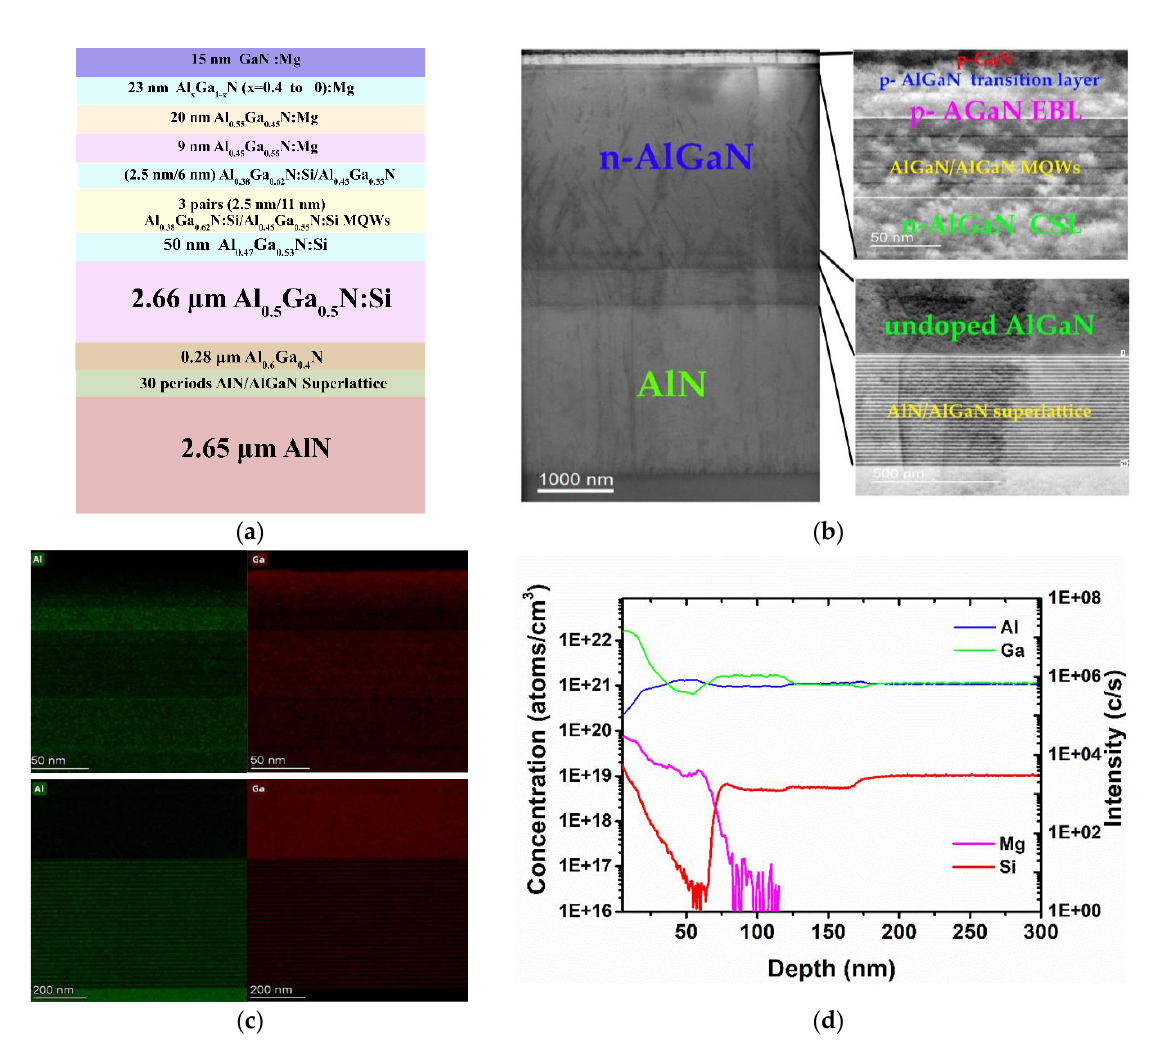
Figure 1. ( a ) Schematic representation of the heterostructure of the investigated 293 nm AlGaN-based UVB-LED. ( b ) TEM image of the 293 nm AlGaN-based UVB-LED structure. Insets: (top) Enlarged TEM image revealing the MQW and p-layer structures; (bottom) enlarged TEM image revealing the AlN layer and superlattice structures; ( c ) (top) EDX mapping image revealing the variable composition of Al and Ga in the MQW and p-layer structures; (bottom) EDX mapping image revealing the variable composition of Al and Ga in the undoped AlGaN and superlattice structures. ( d ) SIMS depth profiles of Mg, Si, Al, and Ga atoms in the 293 nm AlGaN-based